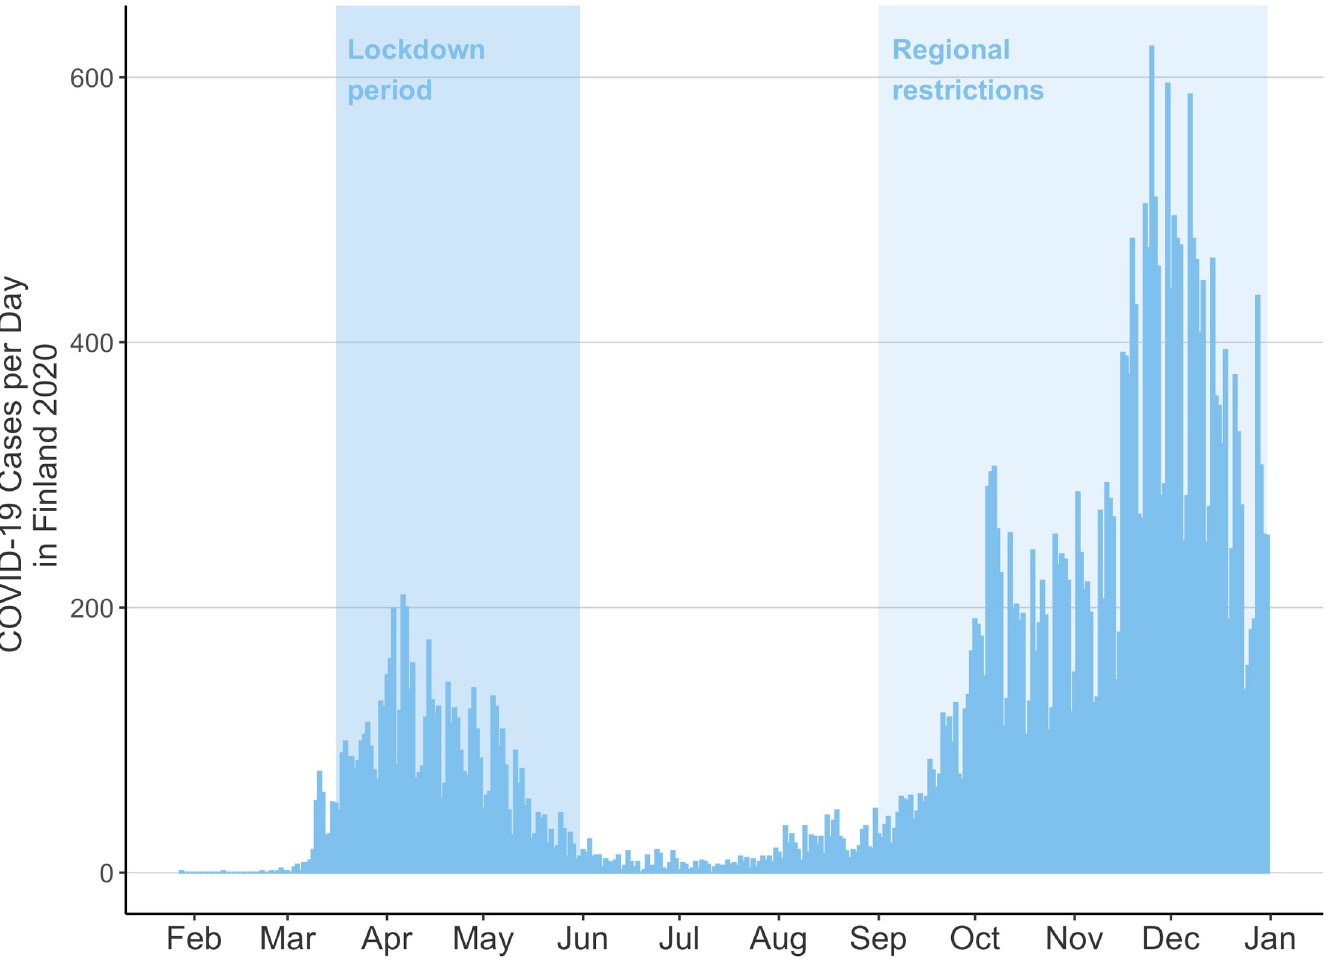
Fig 3. Daily number of PCR test-positive COVID-19 findings in Finland in 2020.